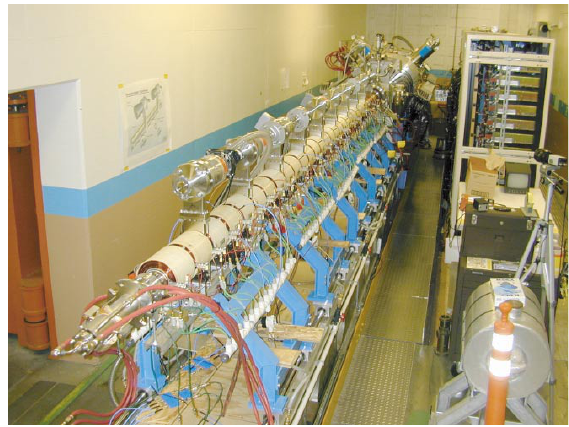
FIG. 7. (Color) Repeating beam line section in BNS experiment.